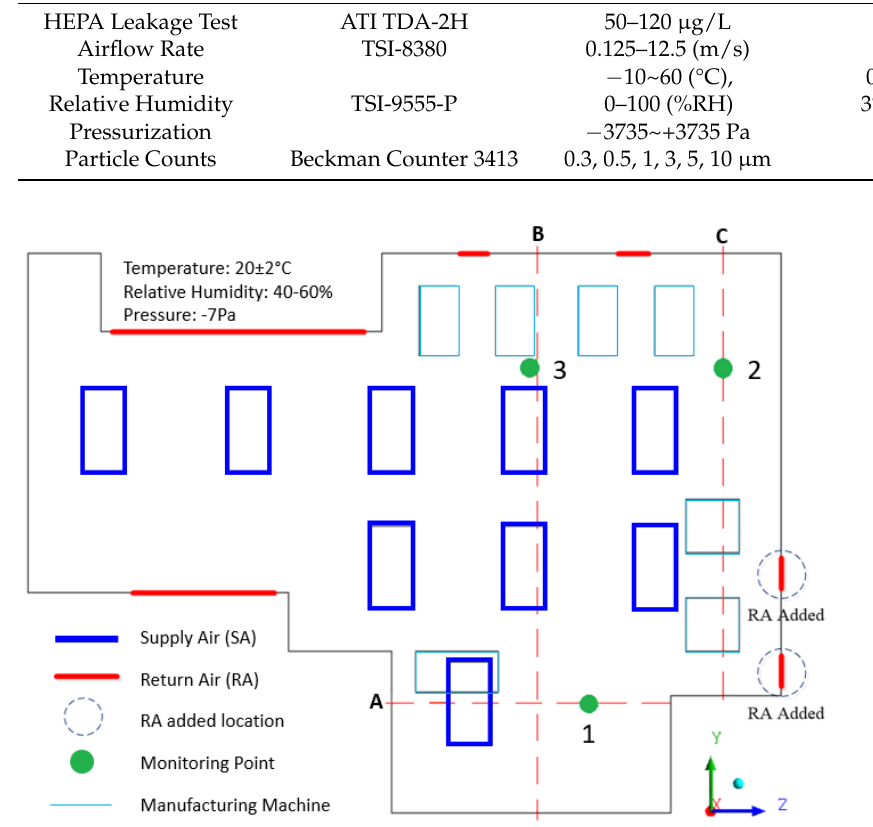
Figure 4. The layout of the investigated biotech cleanroom for CFD simulation. Table 2. The boundary condition for numerical simulations.